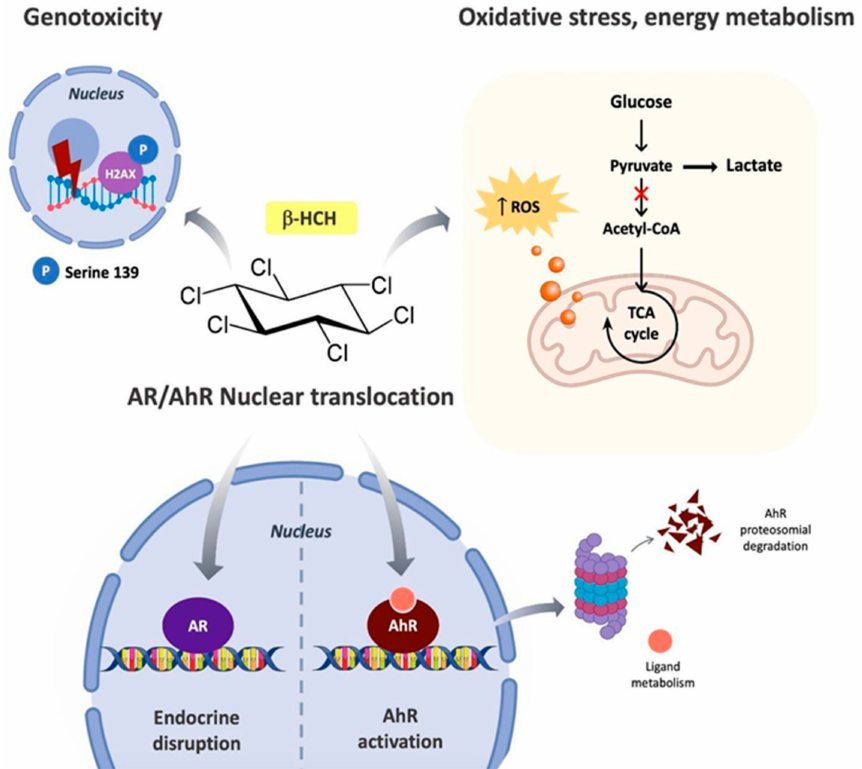
Figure 11. The multifaceted e ff ects of β -HCH on intracellular biochemical